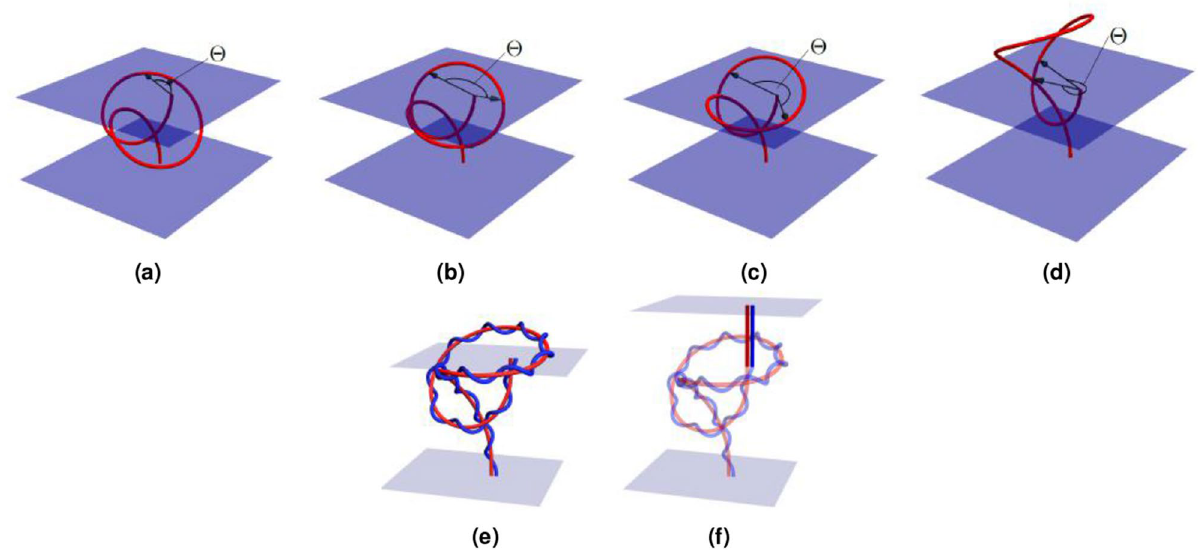
Figure 11. Illustrations of the loss in writhing which occurs to a section of the curve’s interior looping over one of its end points and the extension used to make this loss a discontinuous jump which tracks the pulled tight topology of the ribbon. ( a ) An interior section of the curve rises above one of the planes containing the curve’s endpoints. The angle (cid:31) represents the difference of two contributions to the W pnl calculation which involves angles made with the curve’s end point. In ( b , c ) the curve section rises higher and the angle (cid:31) increases. In ( d ) the angle is nearly 2 π and the curve section has (just) passed directly over the top of the curve’s end. ( e ) is a ribbon corresponding to one of the curves in Fig. 11; a section of the curve is in the plane above the ribbon’s end points. ( f ) The planar extension to the ribbon is shown. Now the whole ribbon structure is bounded between two planes. The extension is composed of planar curves with no twisting.